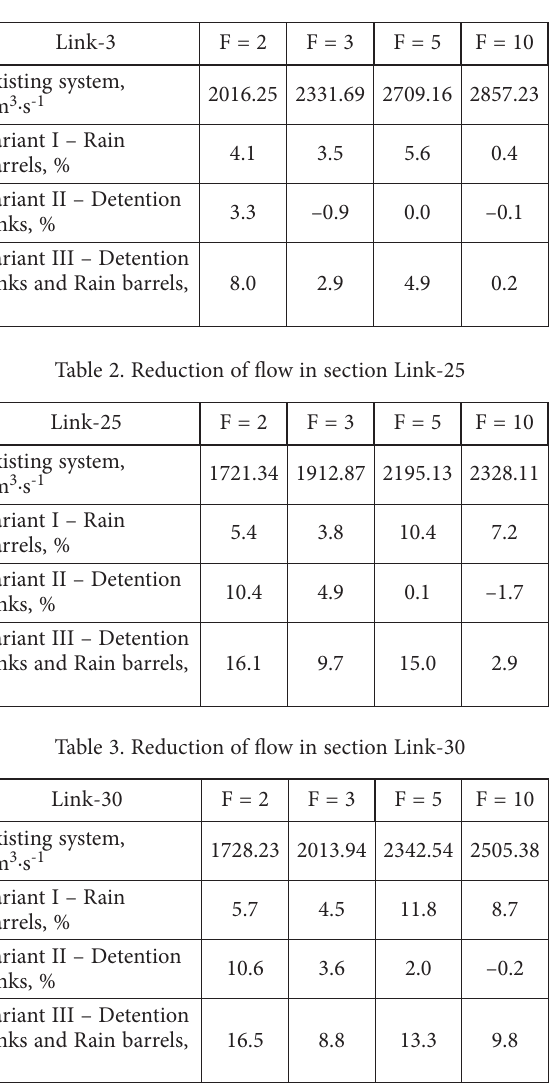
Table 1. Reduction of flow in section Link-3